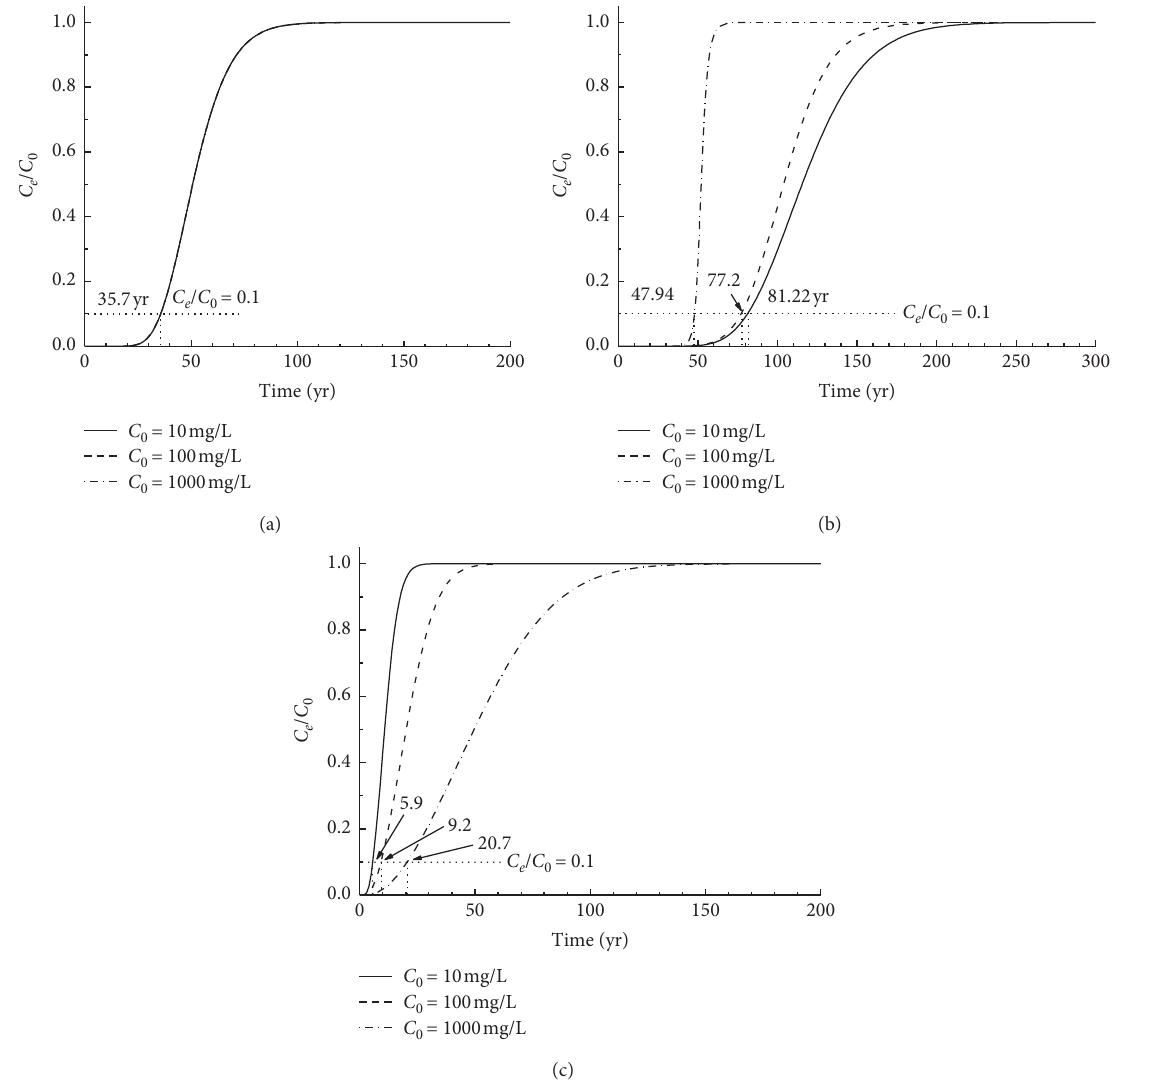
Figure 3: Outflow concentration curve of different concentrations. (a) Cases 1 ∼ 3 (straight type). (b) Cases 4 ∼ 6 (convex type). (c) Cases 7 ∼ 9 (concave type).